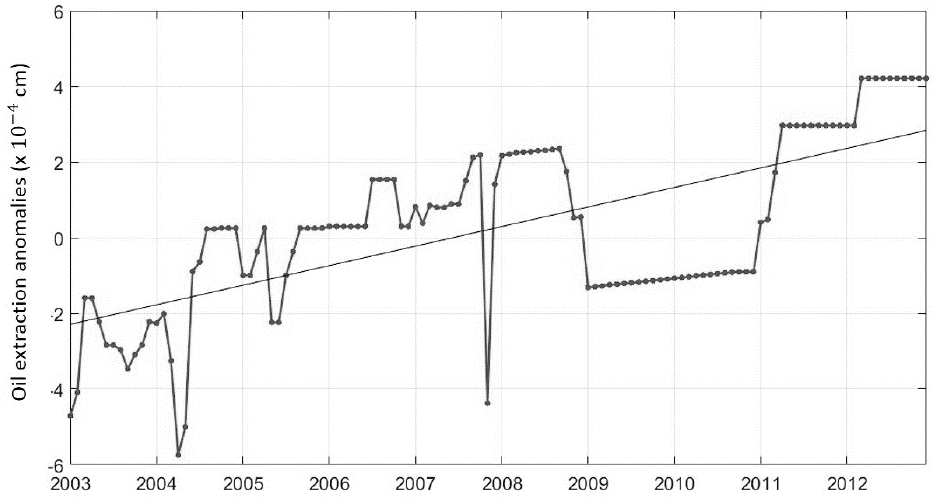
Figure 10. Time series of the oil extractions anomalies as equivalent water thickness from 2003 to 2012. Terrestrial water storage from GRACE, soil moisture from GLDAS and oil extractions from observational data are introduced in Equation (2) to obtain the groundwater anomalies shown in Figure 11. Oil anomalies and TWS include 10 years of data from 2003 to 2012. However, due to the limitation imposed by the soil moisture data, the groundwater time series includes only 8 years, from 2003 to 2010. As seen in Figure 10, the oil effect is very small compared to the change in water not affecting significantly in the estimation of groundwater. After subtracting the soil moisture component, the groundwater time series shows a decreasing trend of 0.5 cm/year with a deviation around the mean of 0.63 cm/year for the study region. This decrease corresponds to an average